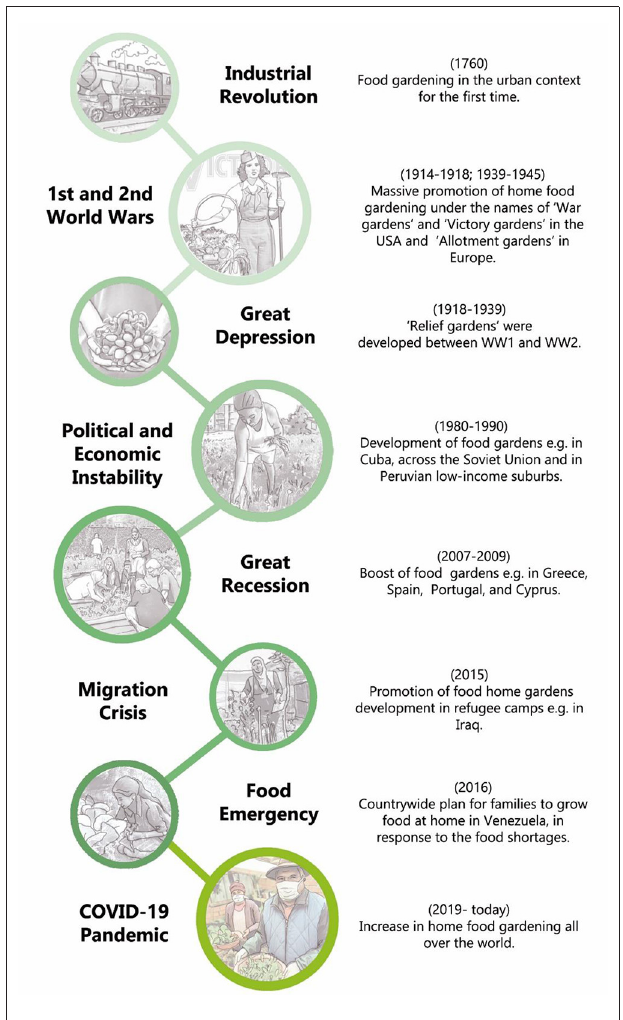
FIGURE 1 | The history of food gardening through time, pointing out examples in crisis times and different geographic contexts. The COVID-19 pandemic is one crisis for urban areas amongst others, in which people relied on the produce of gardens for better livelihood and healthy